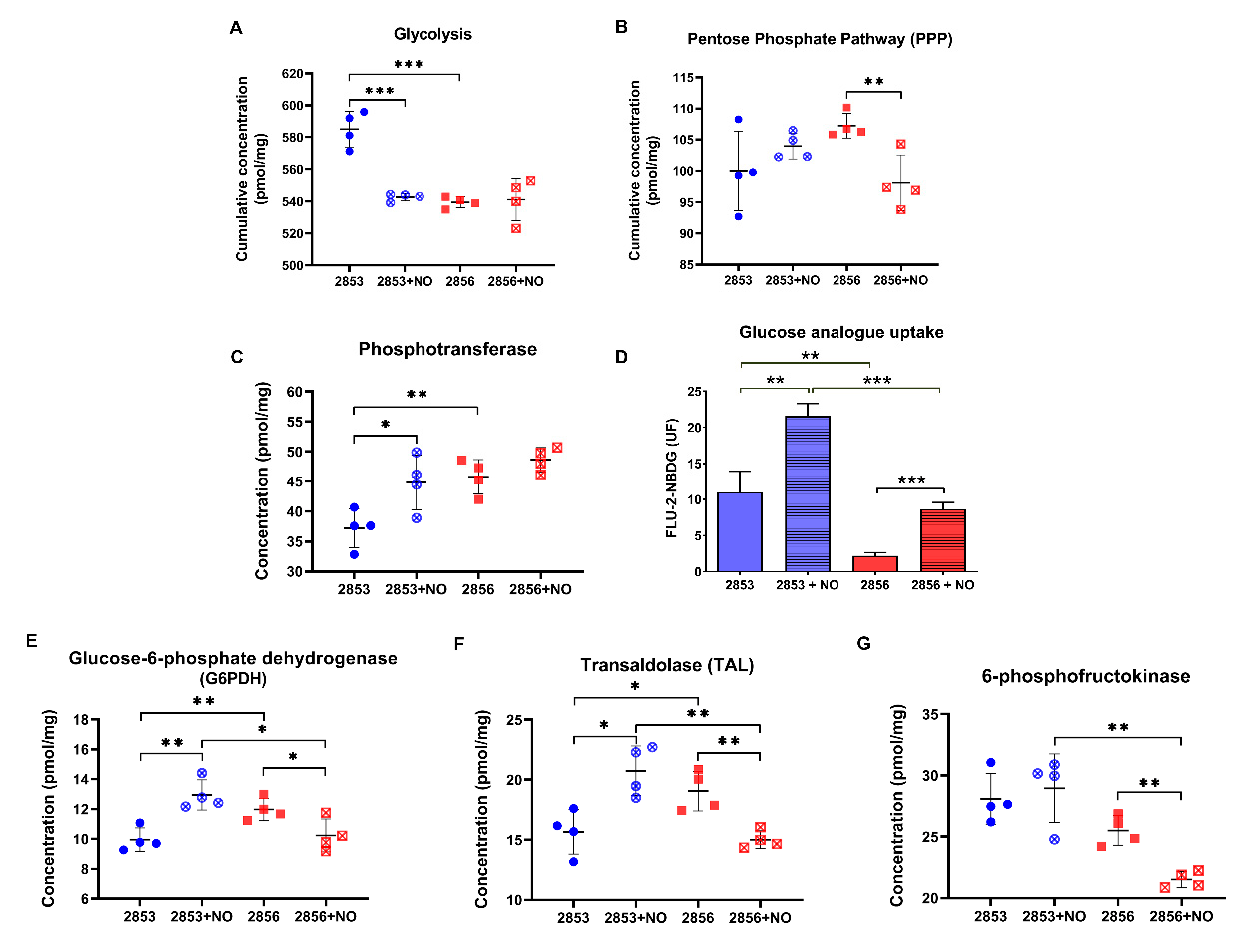
Figure 6. 2-NBDG uptake and G6PDH activity increase in NO-resistant L. braziliensis strain after the nitrosative challenge. Cumulative concentration of all the identified proteins involved in ( A ) glycolysis and ( B ) pentose phosphate pathway (PPP). Each dot represents the total sum of the concentration values of proteins involved in those processes in each of the four biological replicates. Absolute protein concentration of ( C ) phosphotransferase; ( E ) glucose-6-phosphate dehydrogenase (G6PDH); ( F ) transaldolase; and ( G ) 6-phosphofructokinase-1. ( D ) 2-NBDG uptake after parasite incubation for 30 min at 25 °C. Median values were obtained by subtraction of fluorescence at 4 °C. Graphs represent mean ± SD of at least four independent experiments. Statistical differences by Student’s t test (* p < 0.05; ** p < 0.01; *** p < 0.001). 2853: NO-resistant strain; 2853+NO: NO-resistant strain challenged with 1 / 5 IC 50 /4h NaNO 2 ; 2856: NO-susceptible strain; and 2856+NO: NO-susceptible strain challenged with 1 / 5 IC 50 /4h NaNO 2 .